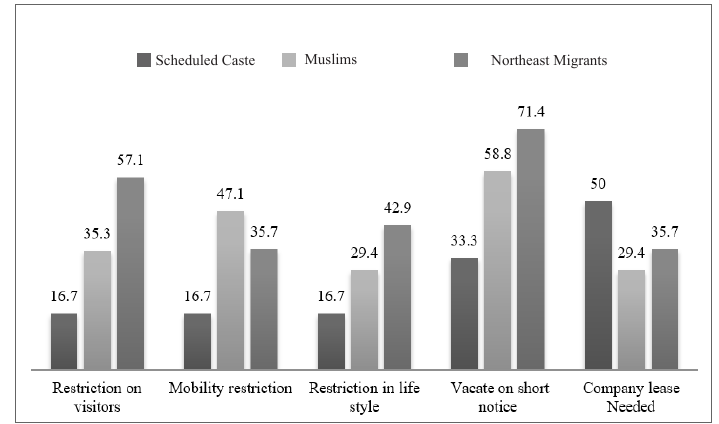
Fig 6. Consequences of Discrimination Source: Primary Field Survey